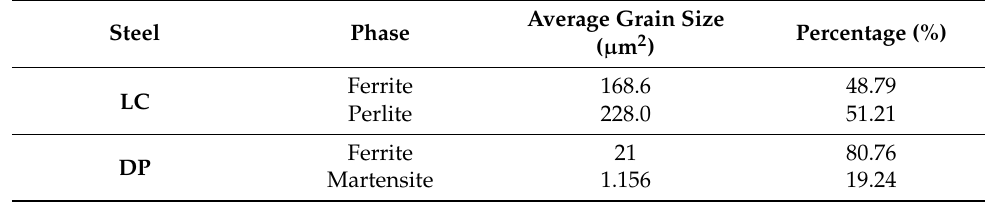
Figure 6. LC steel microstructure obtained by means of SEM. Table 2. Phases percentage in LC and DP